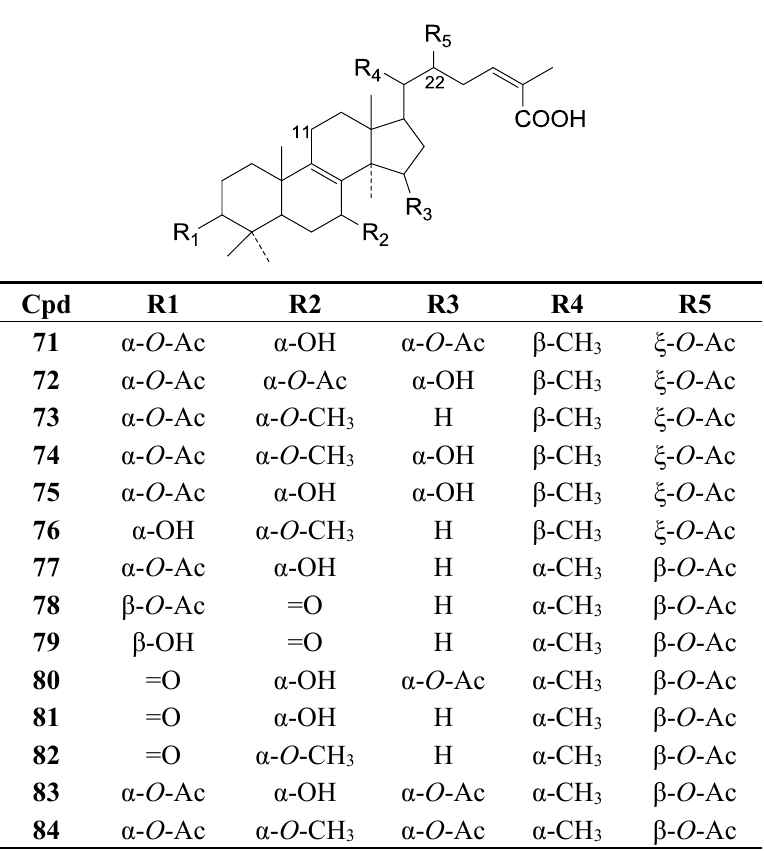
Figure 4. Structures of compounds 71 – 84 .